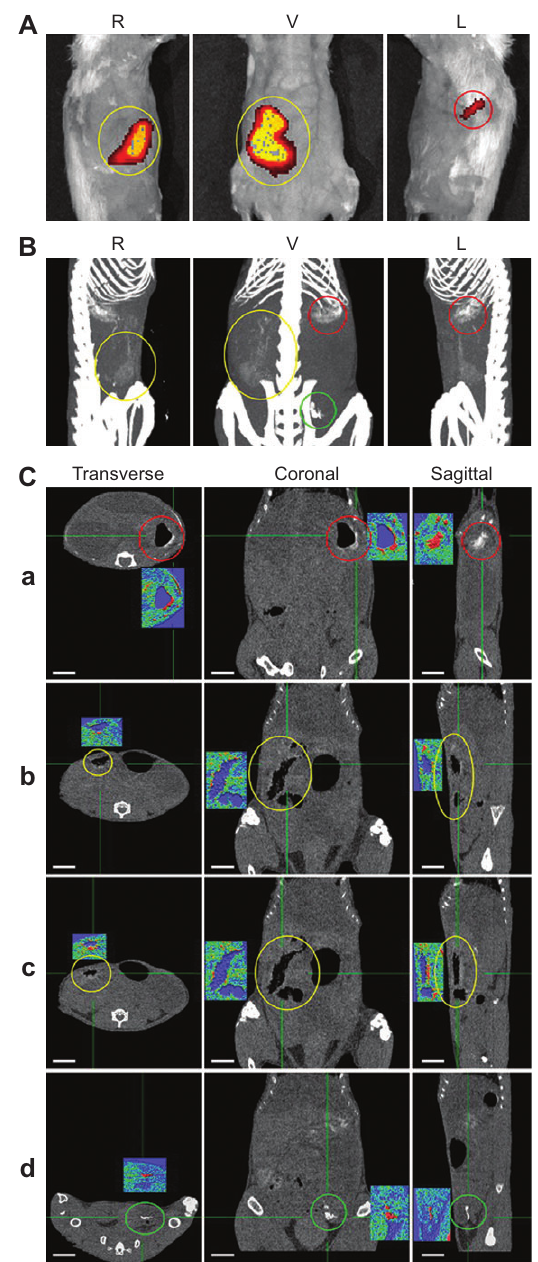
Figure 5 Correlation analysis between in vivo fl uorescence imaging and X-ray CT images. Fluorescence images (A) were compared with X-ray CT images of 3-dimensional (B) and plain images (C) of oral administration of PI particles. A left lateral view (L) of fl uorescence imaging showed weak fl uorescent intensity in the stomach [(A)L, red circles], but the CT images showed high CT signal intensity [(B) L and (C)a, red circles]. However, the X-ray CT images showed high CT signal intensity in the left lower abdomen [(B)V and (C)d, green circles]. All views of fl uorescence imaging showed no fl uorescence [6(B), green circles]. The right lateral view (R) and ventral view (V) of fl uorescence imaging showed strong fl uorescent intensity in the right abdomen [(A)V and (A)R, yellow circles], but the CT images showed low CT signal intensity (maximum 843) [(B)L and 5(C)b, yellow circles]. From Ref. [69] ; reproduced with kind permission from the American Chemical